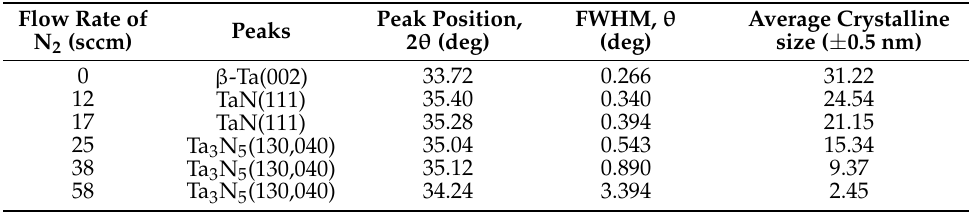
Figure 3. XRD patterns of Ta (20 min) and TaN films deposited for ( a ) 10 min, ( b ) 20 min, and ( c ) 30 min with different N 2 flows. Table 2. Calculated crystallite sizes of Ta and TaN films. Table 2. Calculated crystallite sizes of Ta and TaN films.